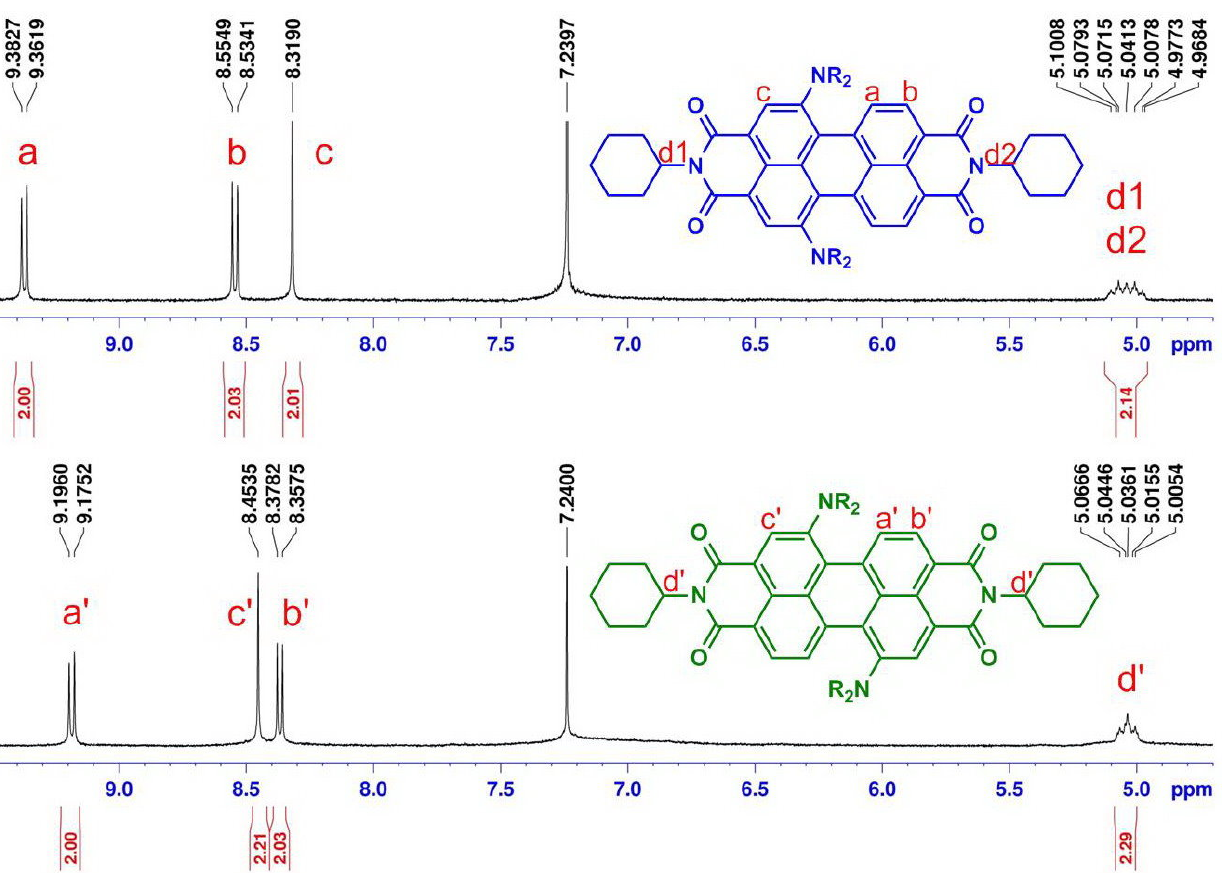
Figure 1. 1 H NMR (400 MHz, CDCl 3 ) partial spectra of regioisomerically pure perylene bisimides 3a (bottom) and 4a